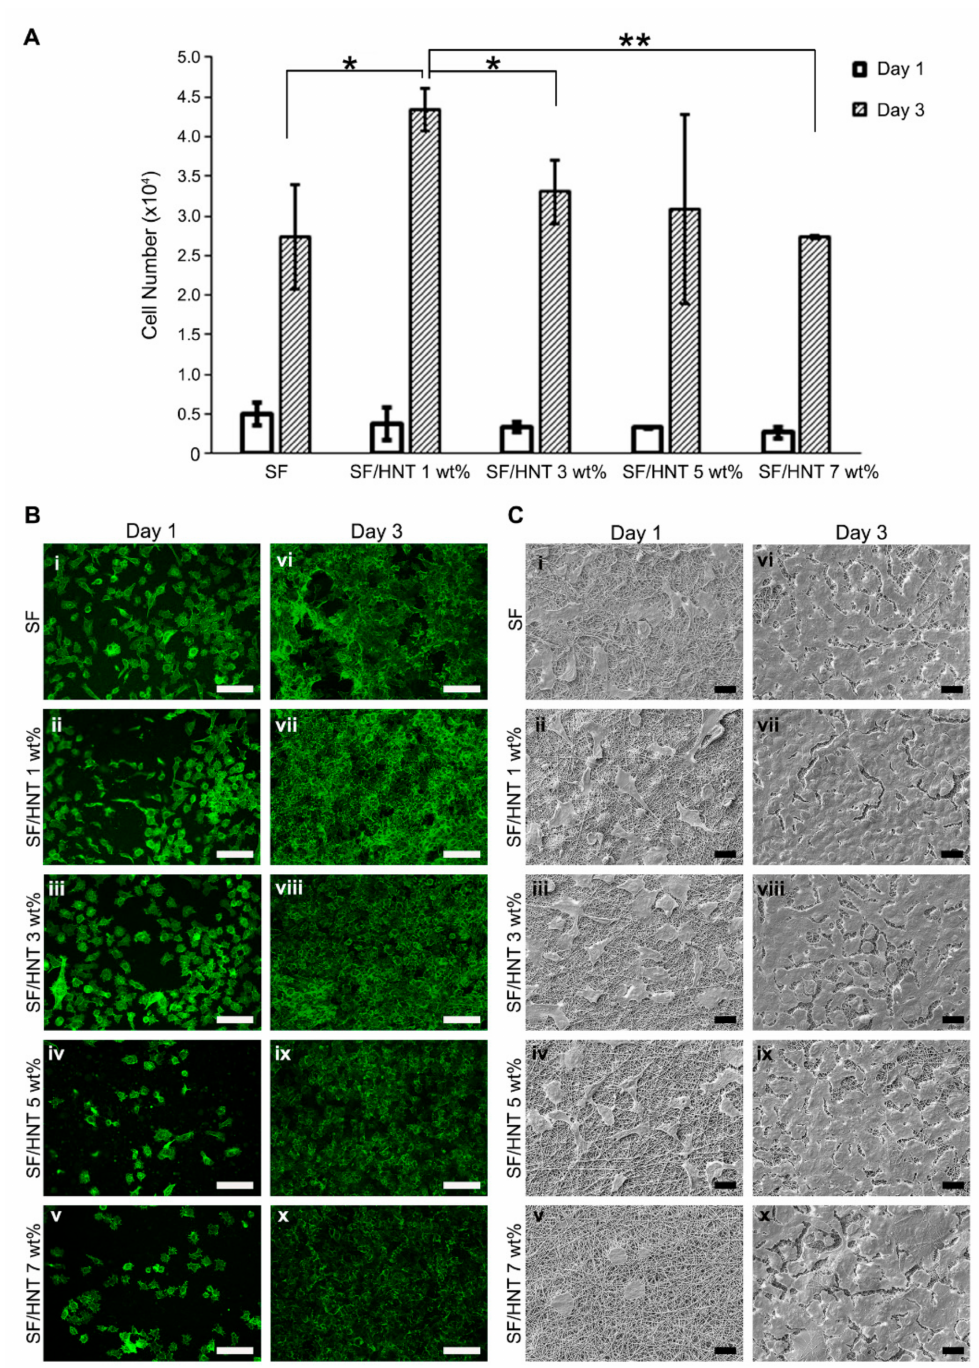
Figure 6. Fibroblasts proliferate on SF and SF/HNT composite scaffolds. ( A ) The numbers of 3T3 cells after 1 and 3 days of culture. Data are means ± SD of 6 replicates and represent three indepen- dent experiments. Statistical analyses were ANOVA with Fisher’s least significant difference test. * p ≤ 0.05; ** p ≤ 0.01. ( B ) Representative images of 3T3 cells cultured for 1 and 3 days on: SF ( i , vi ), SF/HNT 1 wt% ( ii , vii ), SF/HNT 3 wt% ( iii , viii ), SF/HNT 5 wt% ( iv , ix ) and SF/HNT 7 wt% ( v , x ), after staining with phalloidin-Alexa Fluor 488 (Green). Scale bar: 50 µ m. ( C ) FE-SEM images of cells cultured for 1 and 3 days on: SF ( i , vi ), SF/HNT 1 wt% ( ii , vii ), SF/HNT 3 wt% ( iii , viii ), SF/HNT 5 wt% ( iv , ix ) and SF/HNT 7 wt% ( v , x ); scale bar: 10 µ